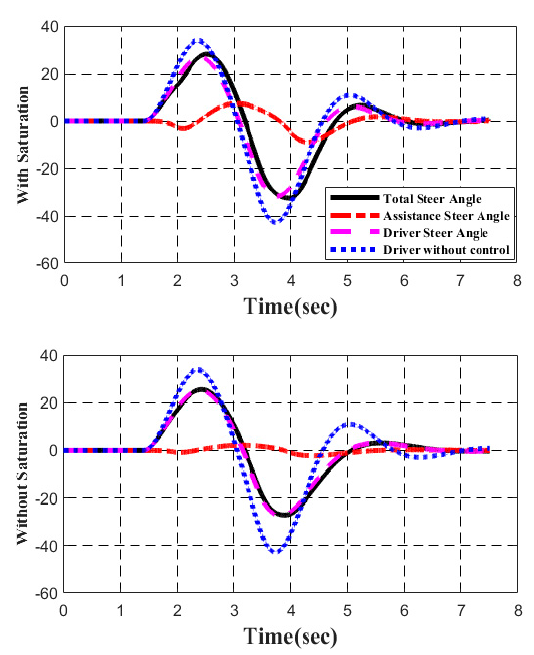
Figure 5. The simulation results for the steer angle.